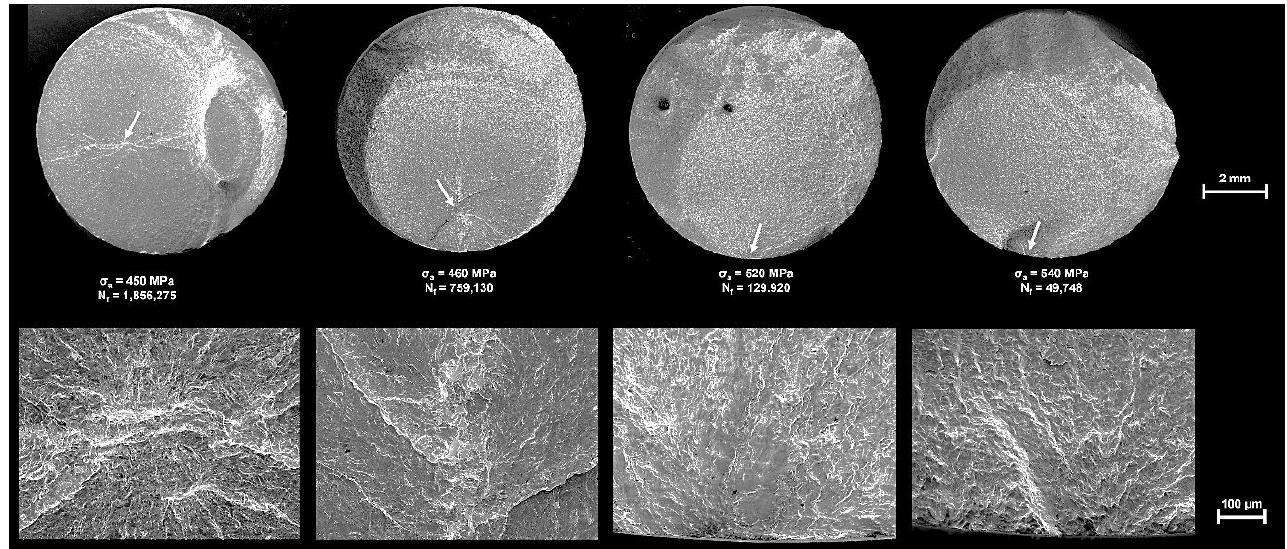
Figure 6. Fracture surfaces of the dr_855N_550 °C condition after cyclic loading at loading amplitudes of 450, 460, 520 and 540 MPa. The pictures below the overview images of the fracture surfaces show magnified details of crack initiation sites marked with white arrows in the overview. For fracture surfaces characterized by multiple crack initiation, only the major site is highlighted and shown in the magnified view.